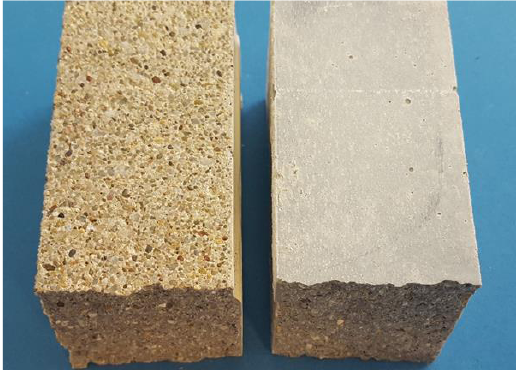
Figure 4. Mortar specimen after 91 days of storage in water (left) and sulfuric acid (right).